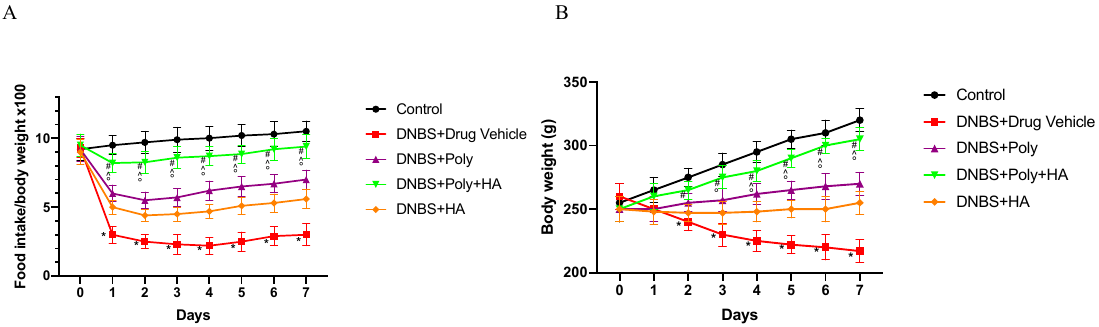
Figure 1. Food intake and body weight evaluated during the experimental period. Values were obtained from 10 animals per group and are expressed as means and SD. Food intake ( A ) * p < 0.0001 vs. control group; # p < 0.0001 vs. dinitrobenzenesulfonic acid (DNBS) + Drug vehicle group. Weight loss ( B ) * p < 0.0001 vs. control group; # p < 0.0001 vs. DNBS + Drug vehicle group; ° p < 0.001 vs. DNBS + hyaluronic acid (HA); ^ p < 0.001 vs. DNBS + polynucleotides (Poly).